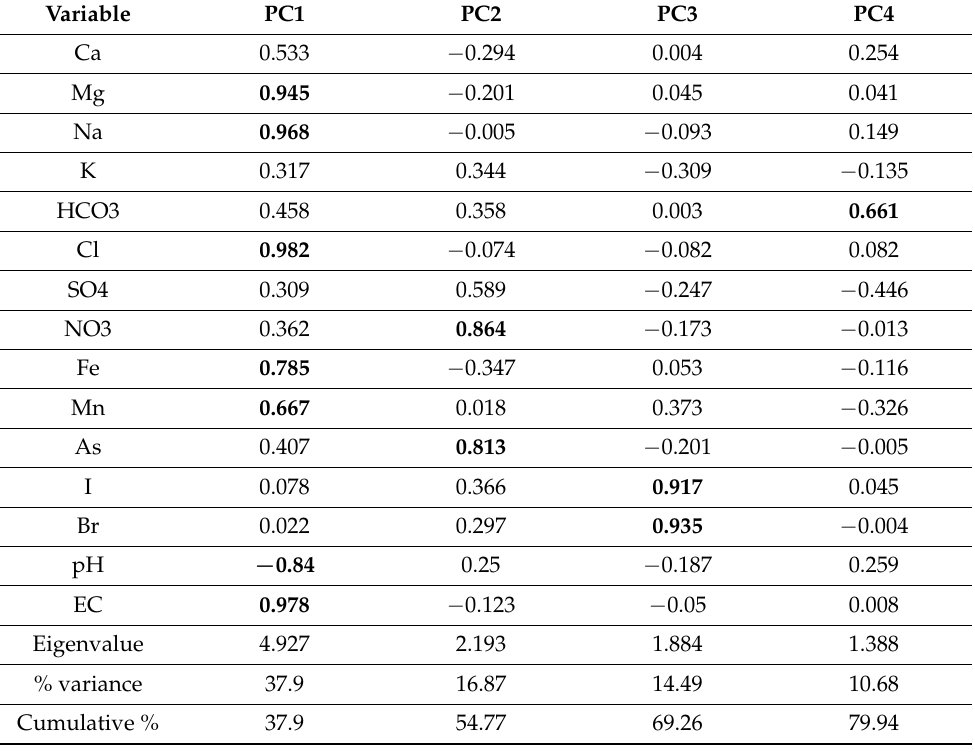
Table 2. Factor loading of each physicochemical parameter of the groundwater with their eigenvalues and variance.